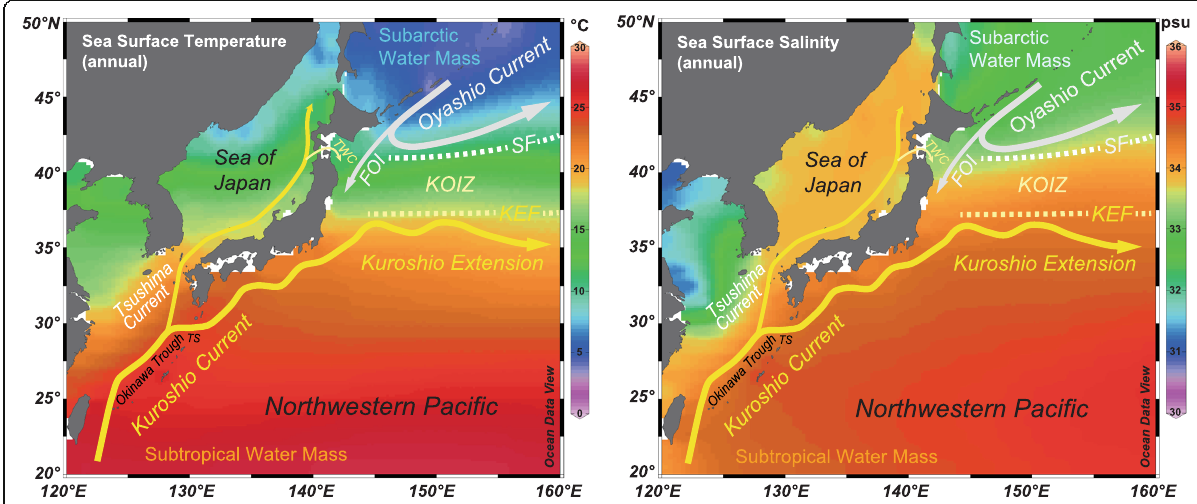
Fig. 2 Present oceanography of the northwestern Pacific Ocean, showing annual sea-surface temperature and salinity from the World Ocean Atlas 2013 (Locarnini et al. 2013) drawn using Ocean Data View software (Schlitzer 2015). Major oceanographic features are included. TWC = Tsugaru Warm Current. FOI = first Oyashio intrusion. SF = Subarctic Front formed by the Subarctic Current, an eastward extension of the Oyashio Current. KEF = Kuroshio Extension Front. KOIZ = Kuroshio – Oyashio Interfrontal Zone, a zone of mixing between the SF and KEF. TS = Tokara Strait. Adapted from fig. 1 of Suganuma et al.